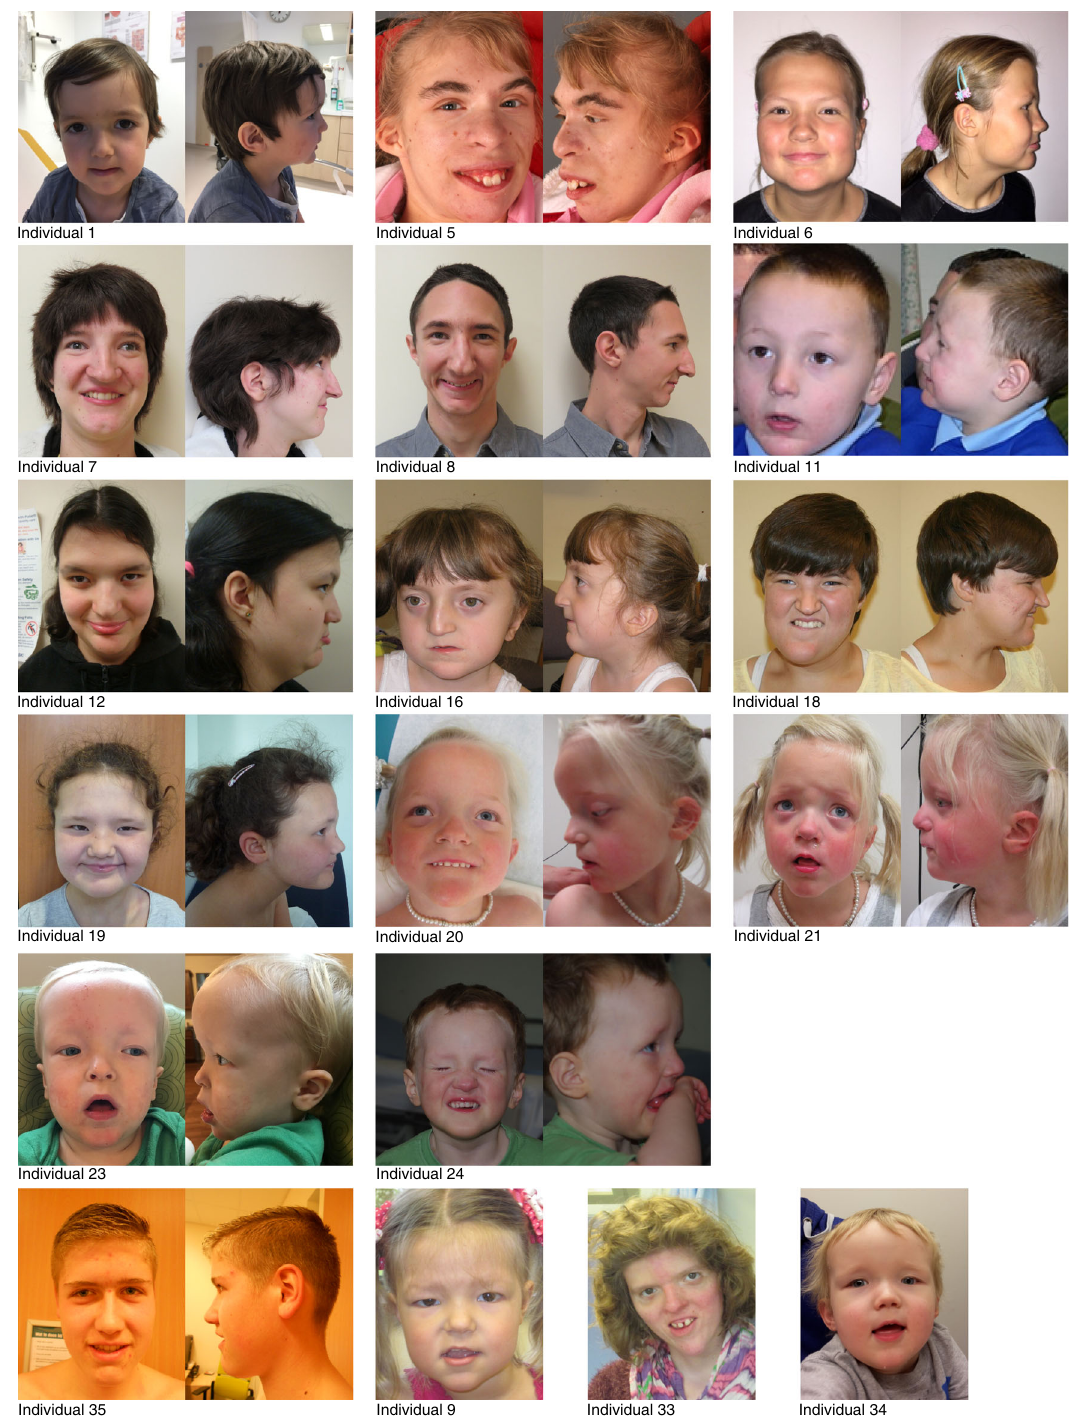
Fig. 1 Photographs of affected individuals. Facial photographs showing dysmorphisms in 18 individuals with de novo CHD3 mutations. The majority of individuals have macrocephaly with a prominent or bossing forehead, individual 5 has microcephaly. Hypertelorism or telecanthus is common, often accompanied by narrow palpebral fi ssures, deep-set eyes, peri-orbital fullness, and/or epicanthal folds. The combination of macrocephaly and deep-set eyes leads to a more prominent supra-orbital ridge. Some individuals show midface hypoplasia. Many individuals have low-set ears that can be posteriorly rotated, and sometimes simple with thick helices. A broad nasal base, prominent nose, a bi fi d nasal tip, and characteristic pointy chin is also frequently seen, as well as laterally sparse